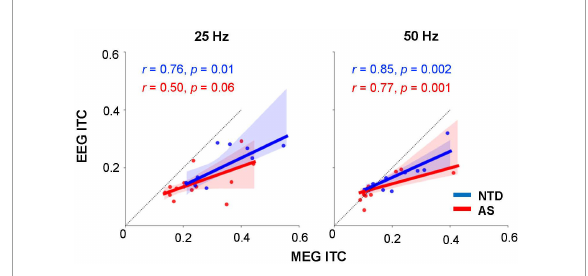
FIGURE5 Relationship between the MEG and EEG ITC measures in individual subjects. Regression lines are shown separately for the two subject groups; shading indicates the 95% confidence interval. The p -values for the correlation coefficients ( r ) were computed using Spearman rank-order test, uncorrected. The dotted line with slope = 1 is shown for reference.